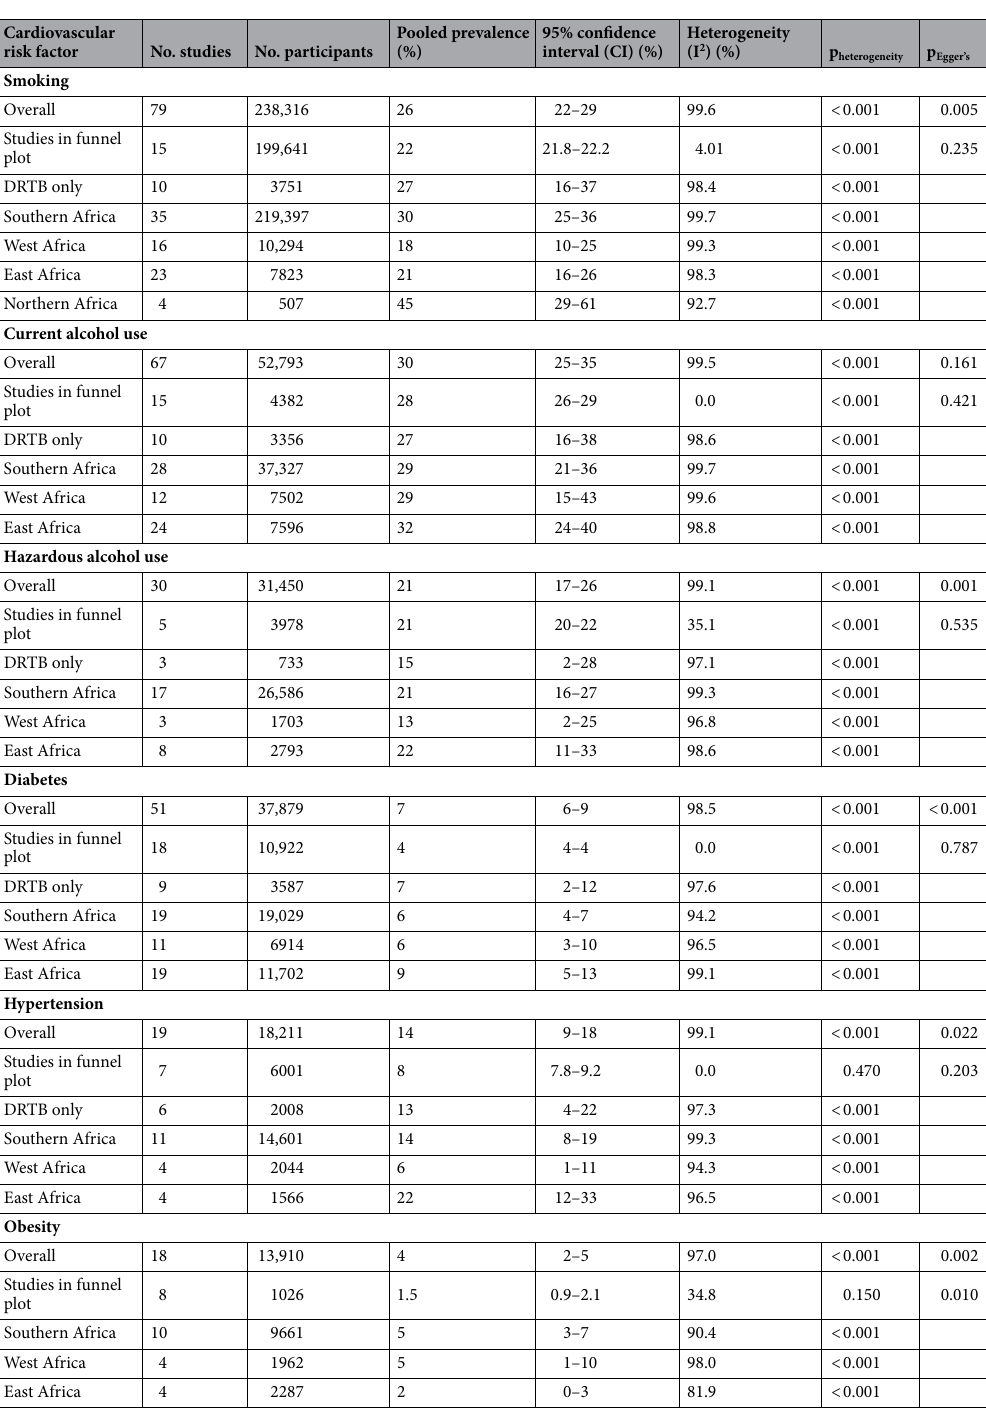
Table 1. Summary Statistics for the prevalence of cardiovascular risk factors among people with active TB in data on physical inactivity (2247 participants). Therefore, meta-analyses for lipid abnormalities and physical inactivity were not performed. Supplementary Tables 1–5 show characteristics of studies included in the meta- analyses for each CVR factor.